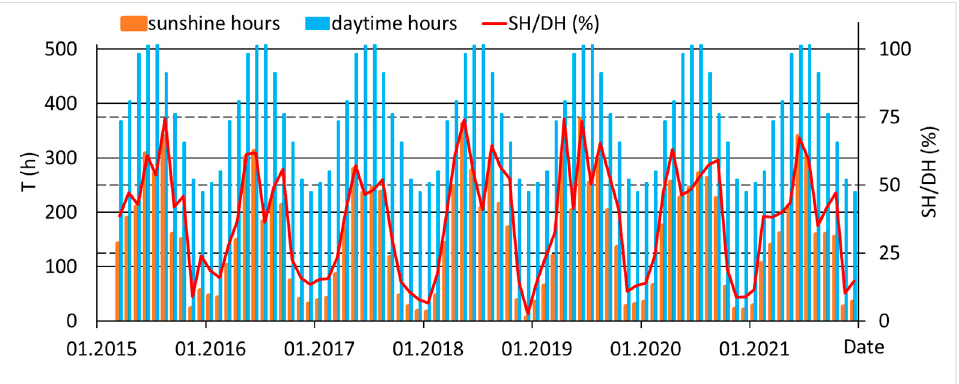
Figure 12. Monthly values of insolation and percentage share of sunny hours in relation to the length of day in Białystok (own elaboration based on [43,44]).